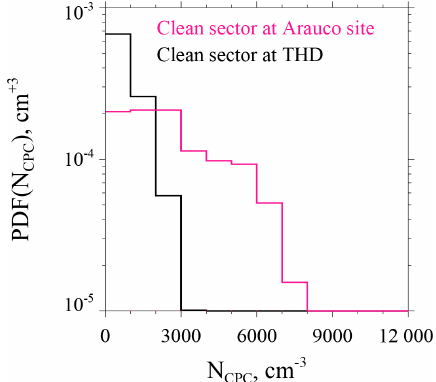
Figure 5. CPC concentration probability distribution functions for the Arauco site and